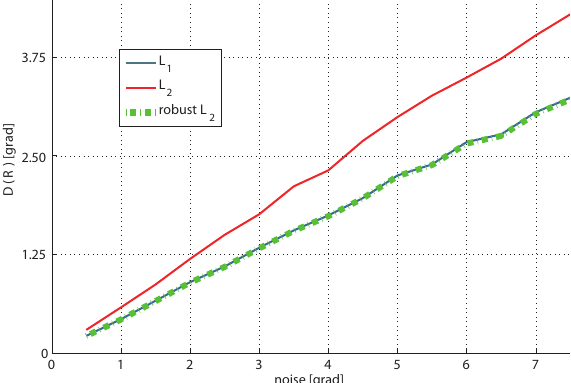
Figure 2: Distance according to (1) between the true rotation and an averaged solution ( L 1 , L 2 and weighted L 2 ) out of five inde- pendent rotation estimates with 10% outlier